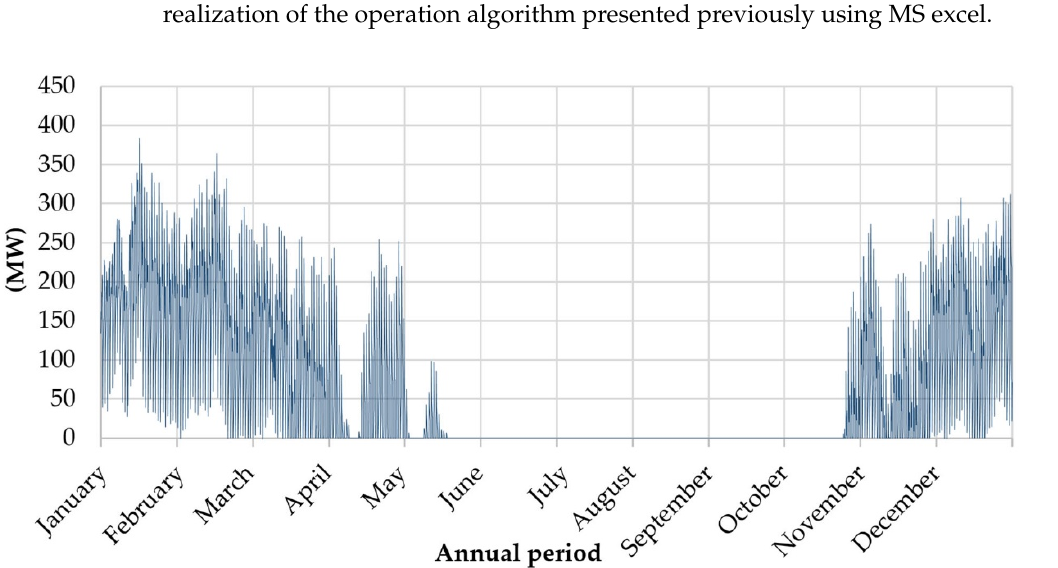
Figure 15. Annual fluctuation in the total heating needs in the residential buildings of the 12 biggest cities and towns in Crete Island, Greece.